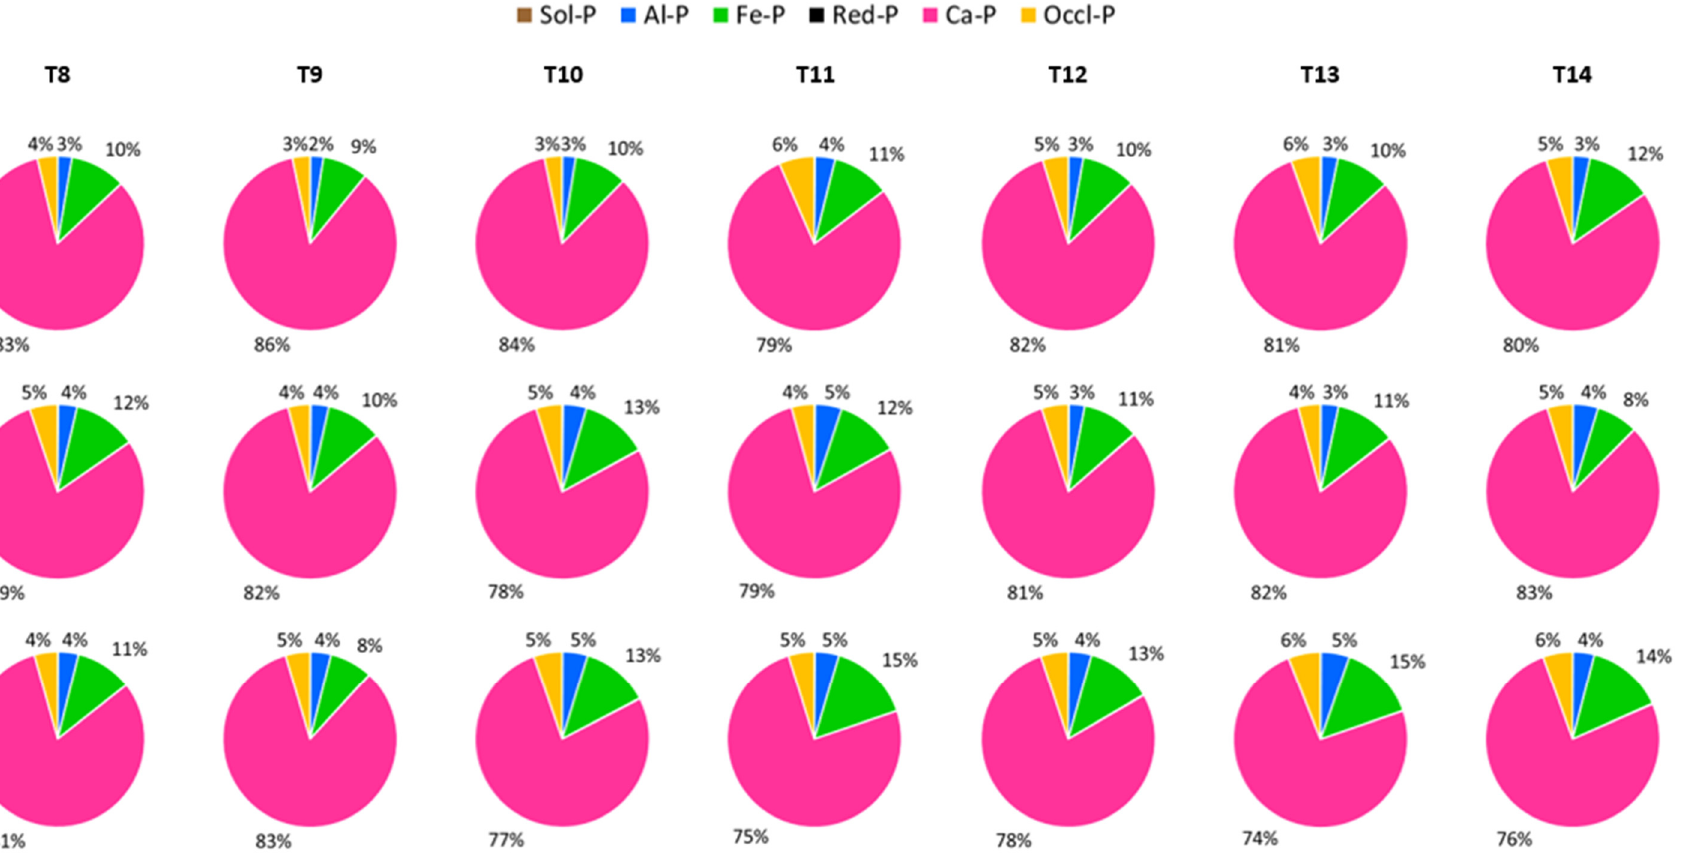
Figure 23. Percentages of soil inorganic phosphorus distribution in T8, T9, T10, T11, T12, T13, and T14 after thirty, sixty, and ninety days of incubation, where T8: Egypt rock phosphate + 25% charcoal + 75% sago bark ash, T9: Egypt rock phosphate + 75% charcoal + 50% sago bark ash, T10: Egypt rock phosphate + 50% charcoal + 50% sago bark ash, T11: Egypt rock phosphate + 25% charcoal + 50% sago bark ash, T12: Egypt rock phosphate + 75% charcoal + 25% sago bark ash, T13: Egypt rock phosphate + 50% charcoal + 25% sago bark ash, and T14: Egypt rock phosphate + 25% charcoal + 25% sago bark ash.